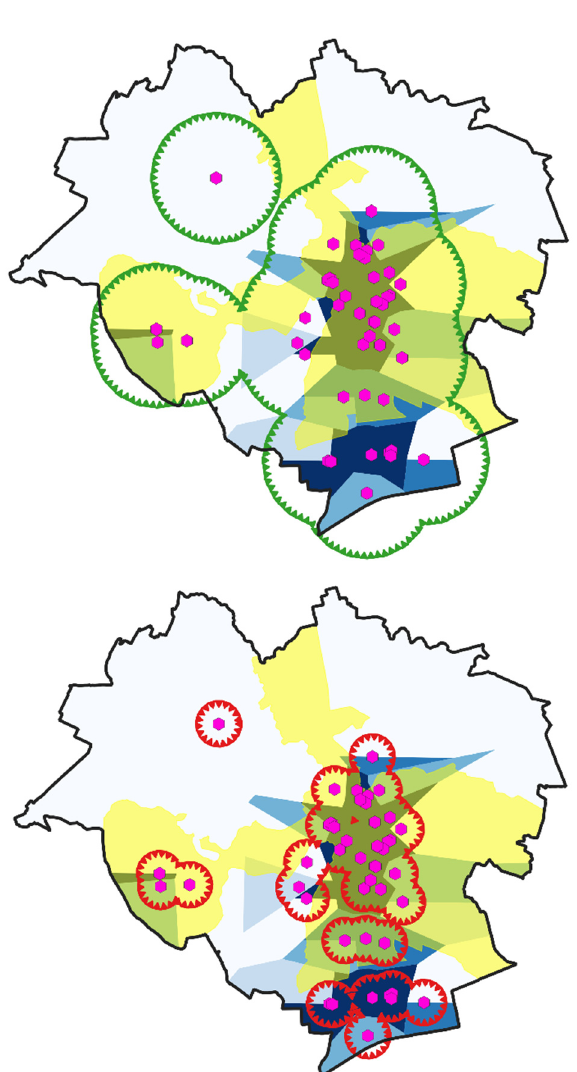
Figure 10. Apparent social dynamics of seniors’ activity on the example of pharmacies and the location of districts inhabited by most of the surveyed seniors in Olsztyn. Source: own elaboration.